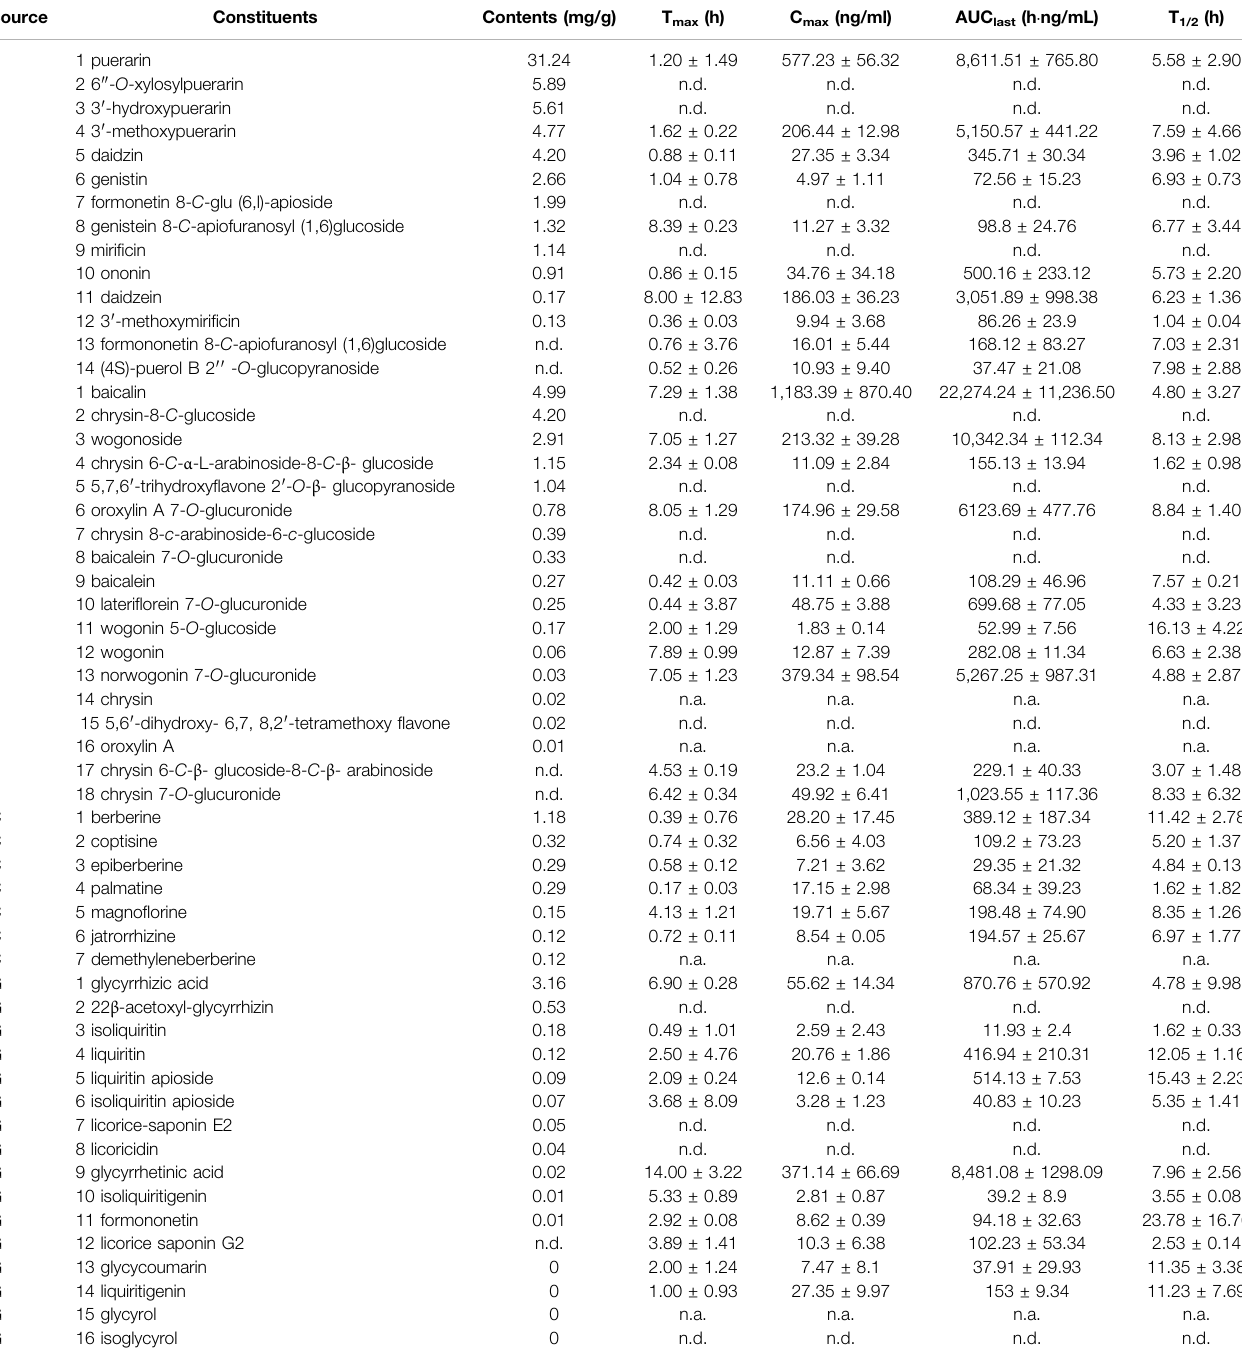
TABLE 1 | Constituents of Gegen-Qinlian decoction (GQD) and their pharmacokinetic parameters obtained in rats that received 18.9 g/kg (1.5-fold of the clinical dosage) oral GQD.